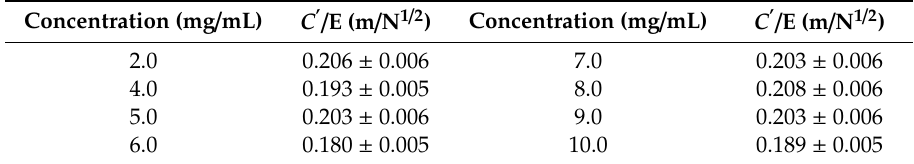
Table 3. The C ’ / E value at the point of